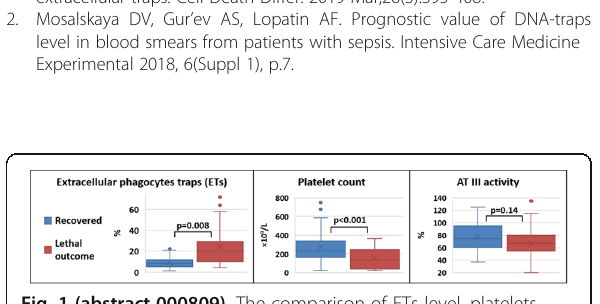
Fig. 1 (abstract 000809). The comparison of ETs level, platelets count and AT III activity.